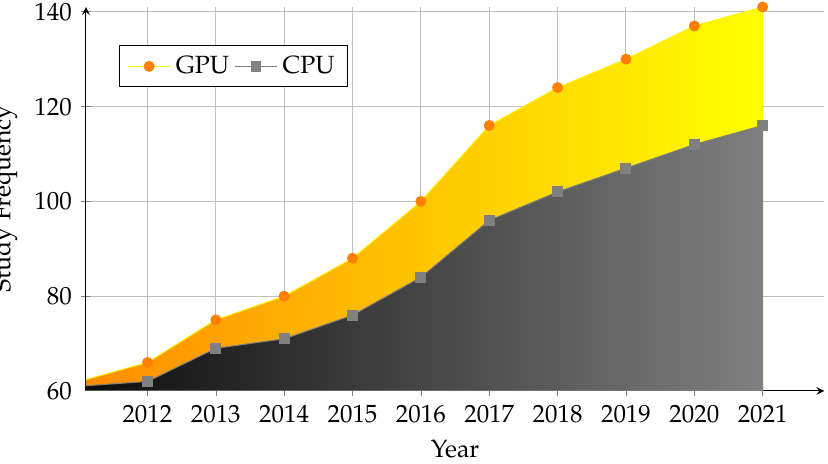
Figure 14. The emergence and increase in use of GPUs based on the power system studies covered in this work. Grey and yellow areas represent the cumulative volume of CPU and GPU based studies